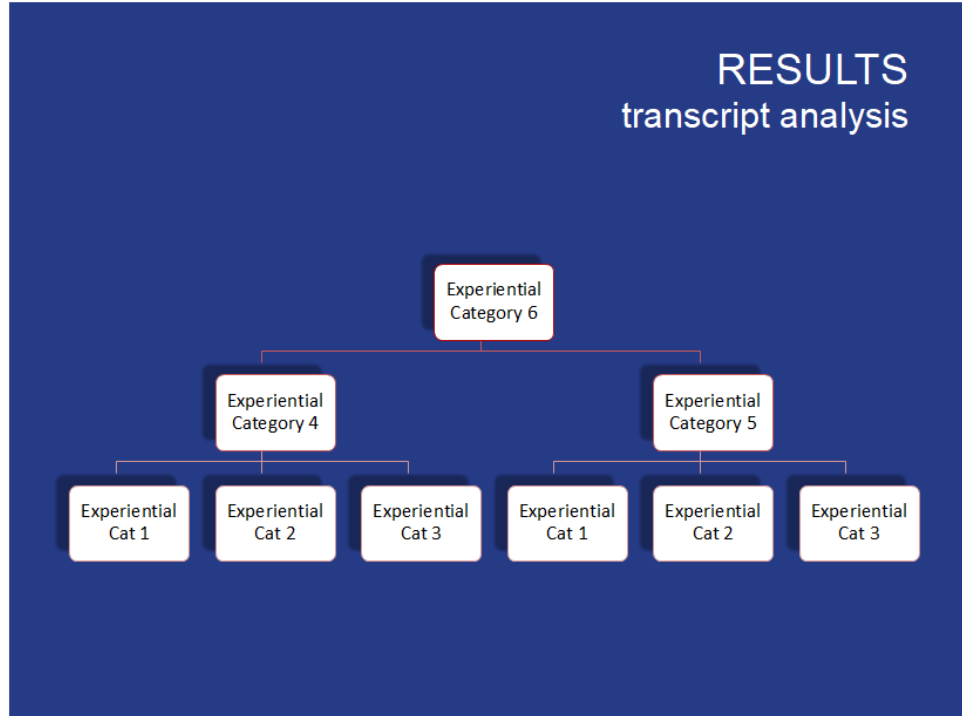
FFigigururee 55 Emerging Patterns in Experiential Categories, Categories.